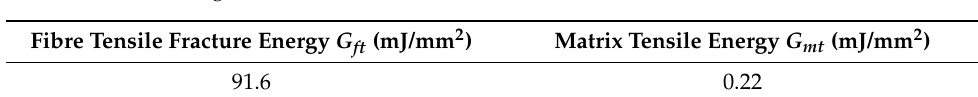
Table 7. Fracture toughness of CFRP fabric.